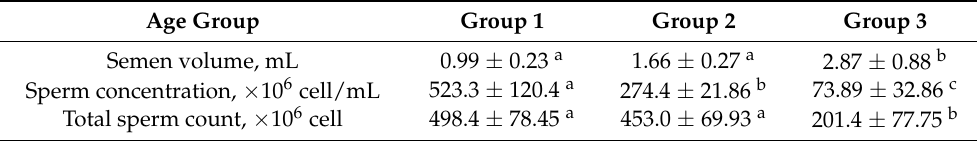
Table 1. Volume of the sperm-rich fraction of ejaculate, sperm concentration, and total sperm count in ejaculates collected from dogs of different age groups (values are means ±